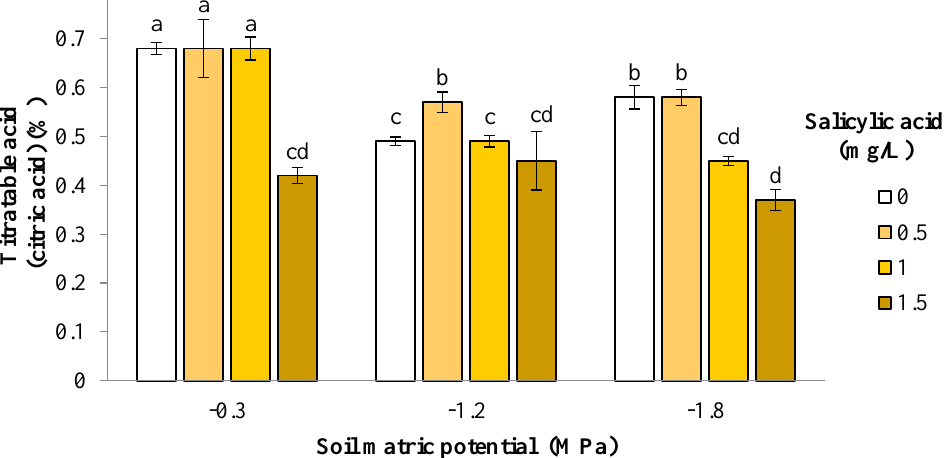
Figure 4. Interaction effects of controlled water stress and foliar application of SA on titratable acid of Pumpkin.